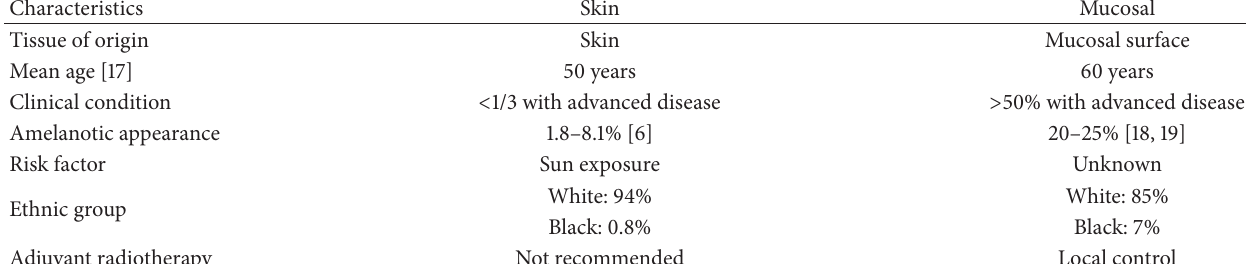
Table 1: Comparison between malignant skin melanoma and mucosal melanoma.